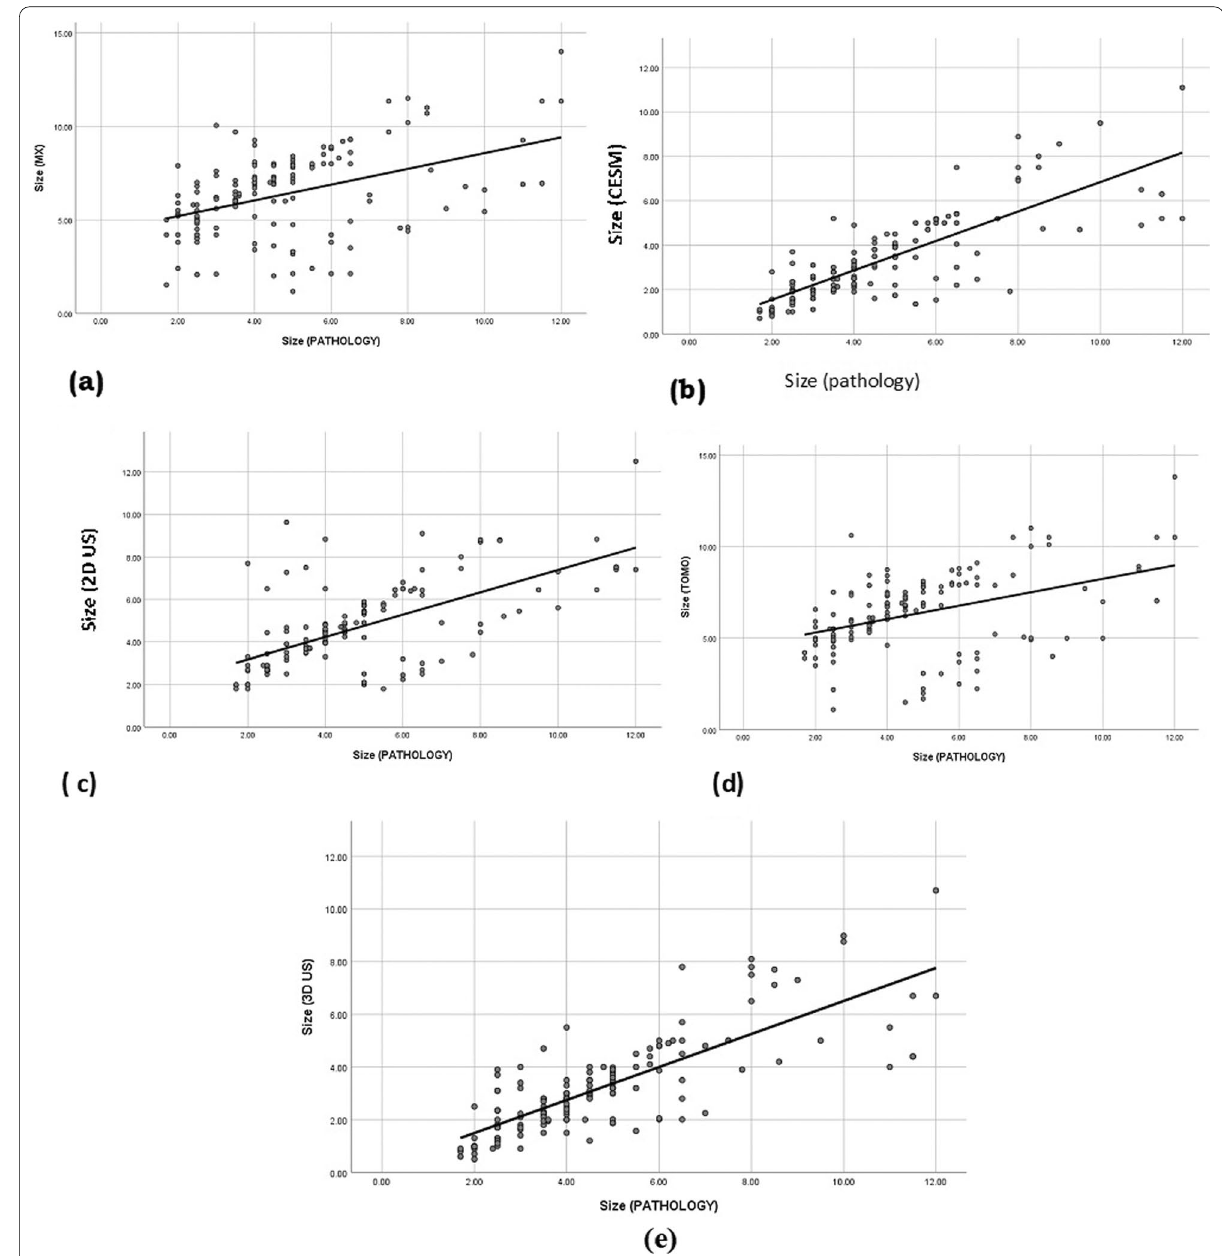
Fig. 1 The correlation between the a DM, b CESM, c 2 D US, d DBT and e 3D US with the